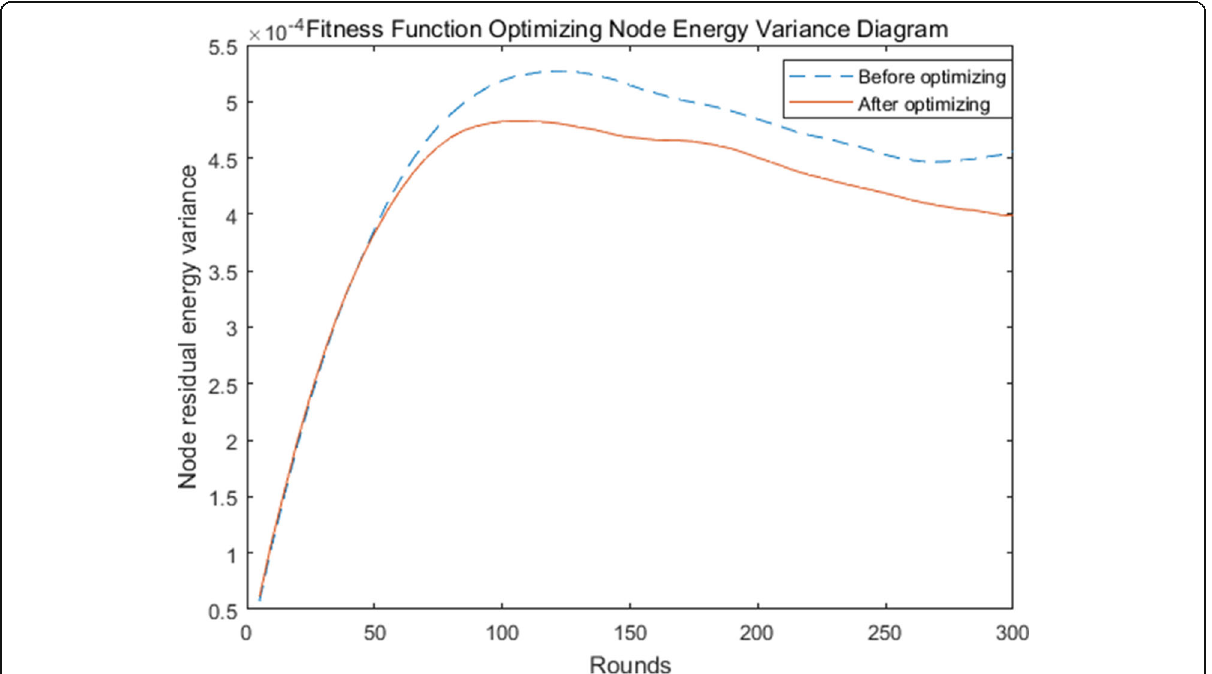
Fig. 14 Fitness function optimizing node energy variance diagram. It is proved that the improvement of fitness function optimizes the network load